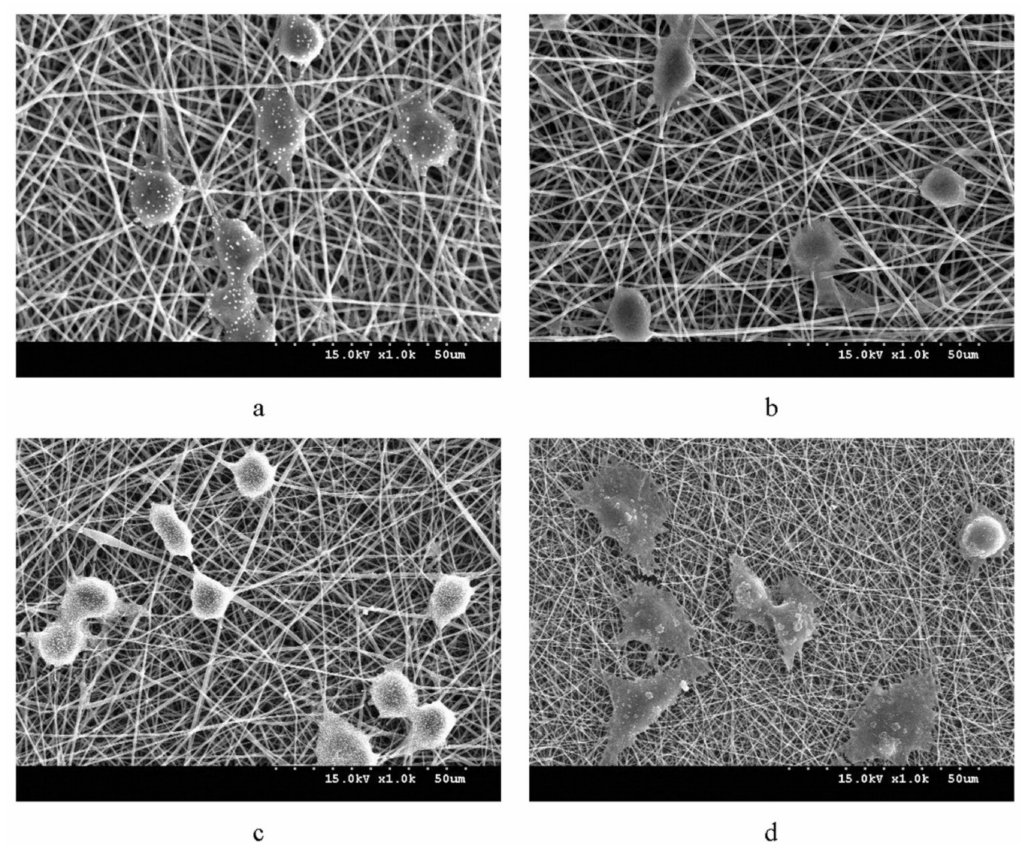
Figure 4. Adhesion of keratin, gelatin, and collagen to the PHBV polymer solution on the growth of fibroblasts has shown that collagen fibers with keratin fibers provided the best adhesion and prolifer- ation reaction. ( a ) PHBV/keratin ( b ) PHBV/gelatin ( c ) and PHBV/collagen ( d ) mats. Reprinted from Wang et al. (2016) [108] with permission from